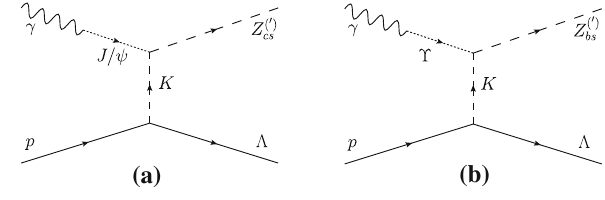
(cid:3) ) photoproduction in the process of a γ p → (cid:3) Z cs / bs ( (cid:3) ) , respectively bs